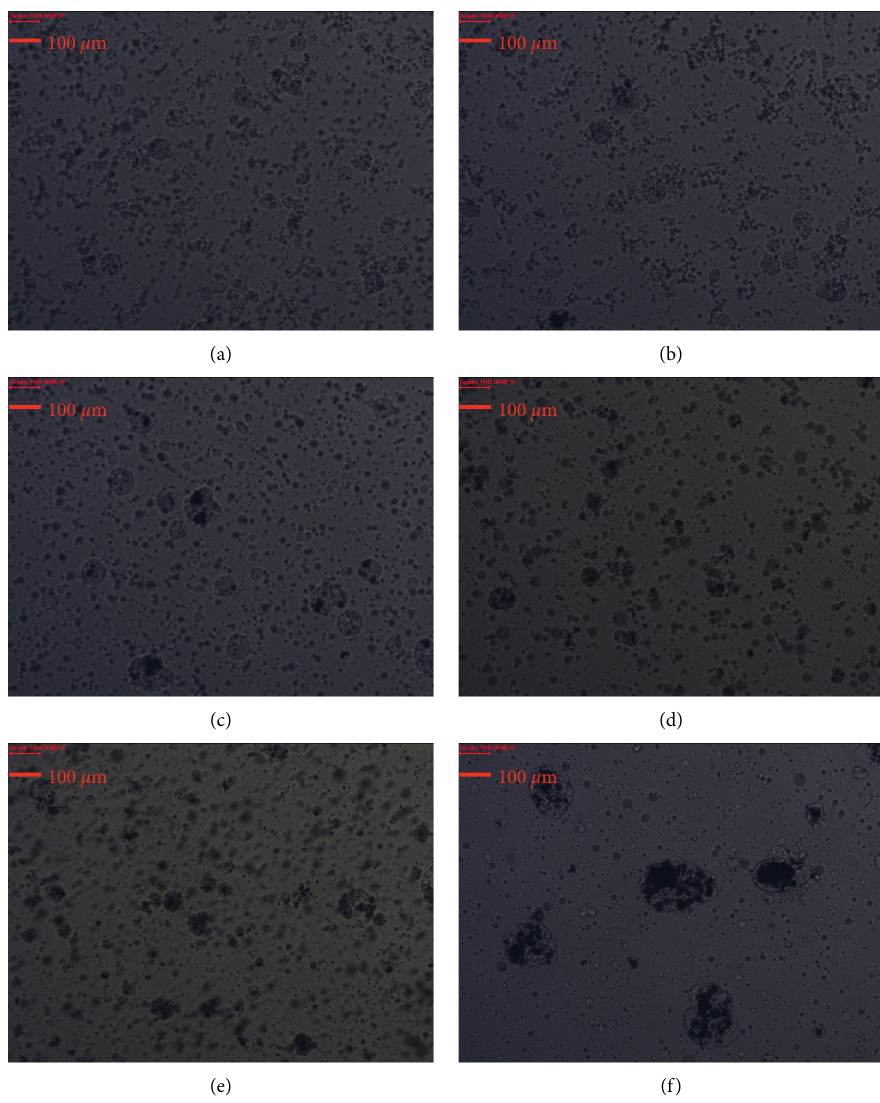
Figure 1: Optical micrograph of (a) Sample 1, (b) Sample 2, (c) Sample 3, (d) Sample 4, (e) Sample 5, and (f) Sample 6. The scale bar:100 μ